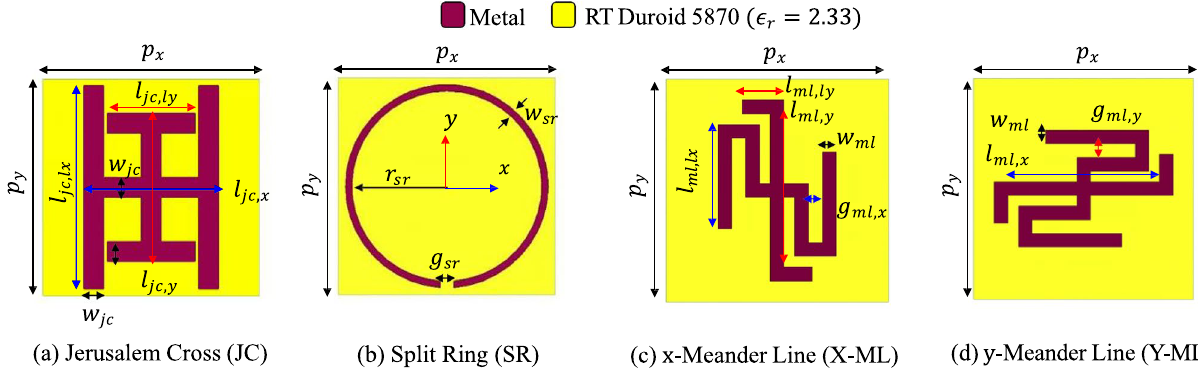
Figure 3. Primitives used for training the GAN: ( a ) Jerusalem cross, ( b ) split ring, ( c ) meander line in x -direction, and ( d ) meander line in y -direction. Ranges of each variable are defined in Table 2.